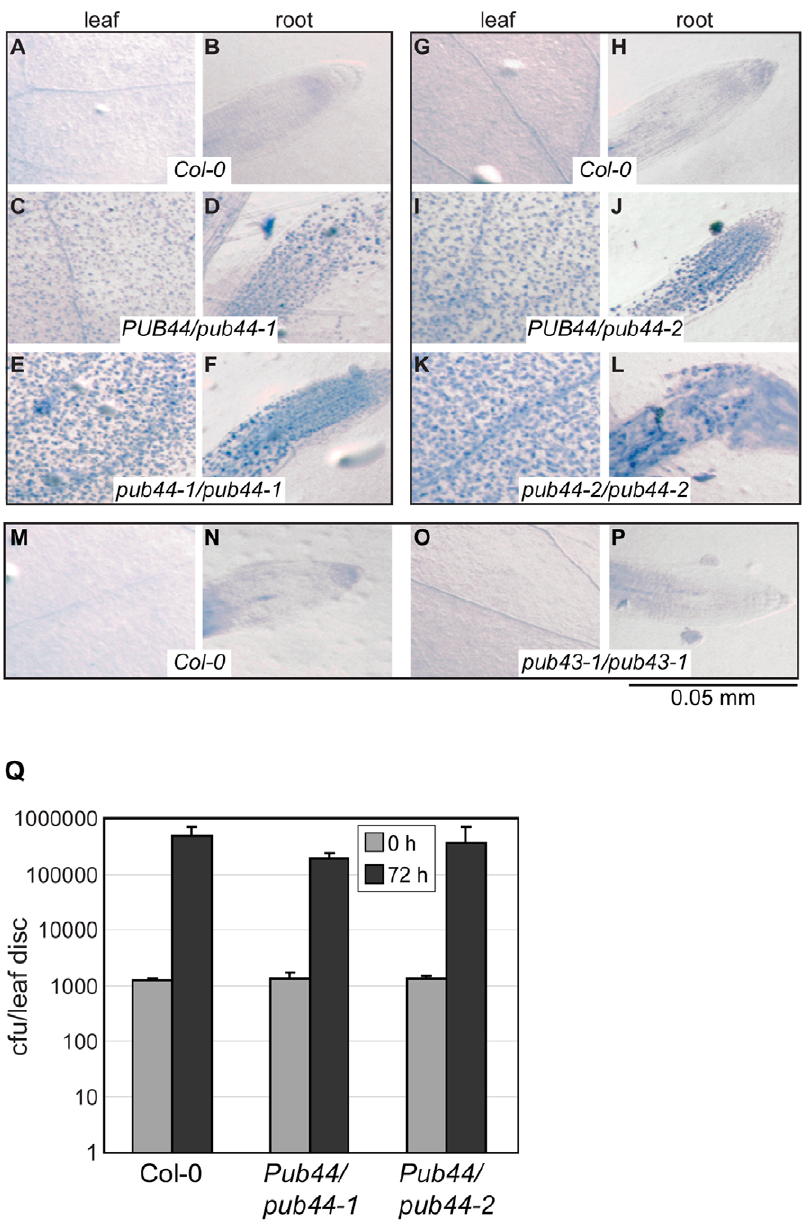
Figure 2. Cell death lesions in PUB44/pub44 plants and responses to Pseudomonassyringaepv . tomato infections. ( A – P ) Trypan blue staining assay for cell death. 3 day old seedlings were stained with trypan blue to further investigate the seedling lethality phenotype associated with the pub44/pub44 genotype. Images of stained cotyledons and roots are shown. Seeds from heterozygous PUB44/pub44 plants were germinated to give seedlings with the three expected genotypes: Col-0 PUB44/PUB44 , PUB44/pub44 , and pub44/pub44 determined by PCR genotyping. The pub44/ pub44 homozygous seedlings showed the greatest amount of trypan blue stained cell death lesions, and the PUB44/pub44 heterozygous seedlings showed an intermediate amount of staining, despite being viable plants. In contrast, the pub43-1/pub43-1 seedlings did not have any detectable cell death lesions. Scale bar=0.05 mm. ( Q ) Responses of PUB44/pub44 plants to pathogen infection. Four-week old Col-0 and PUB44/pub44 plants were infected with Pseudomonas syringae pv . tomato , and bacterial counts were taken after 3 days. The PUB44/pub44 plants showed a similar response to Col-0. Average bacterial counts were taken from plants and graphed with standard error.